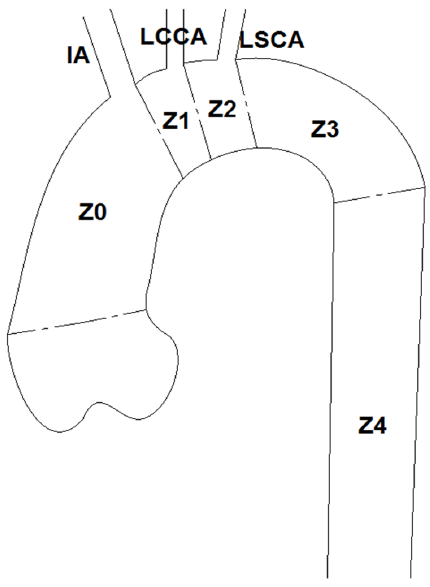
Figure 2. Anatomical map of landing zones in the aortic arch. Note that IA is also known as brachiocephalic artery (BCA) in some literature.